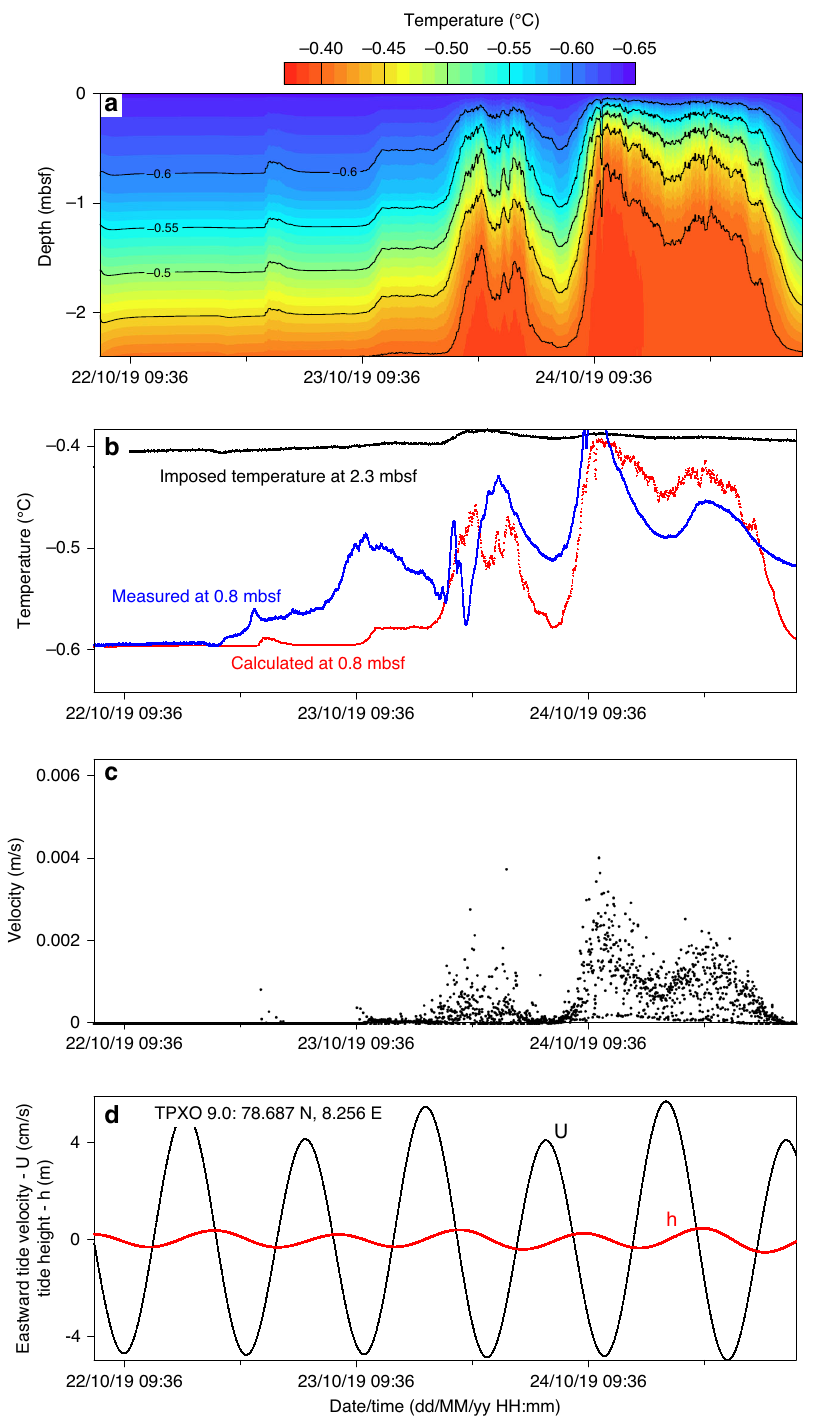
Fig. 6 Thermal and hydraulic processes at PZM1. a Predicted temperature fi eld in the calculation domain. b The calculated temperature at 0.8 mbsf (red curve) is compared to the measured one (blue curve). c The upward fl uid velocity used in the advection calculation. d The black curve indicates eastward tide velocity, while the red one is the tide